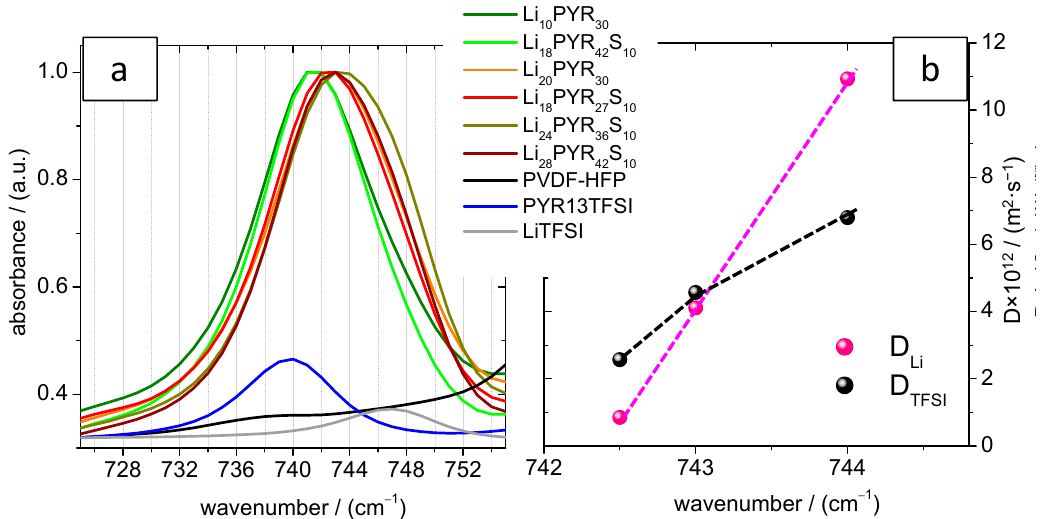
Figure 7. ( a ) The normalized υ (S-N) band of TFSI in all the electrolytes together with the same band in PYR13TFSI and LiTFSI (this spectral region for neat PVDF–HFP is also included), and ( b ) D Li and D TFSI at 25 °C as a function of the position of the υ (S-N) in Li 18 PYR 27 S 10 , Li 24 PYR 36 S 10 , and LI 28 PYR 42 S 10 .